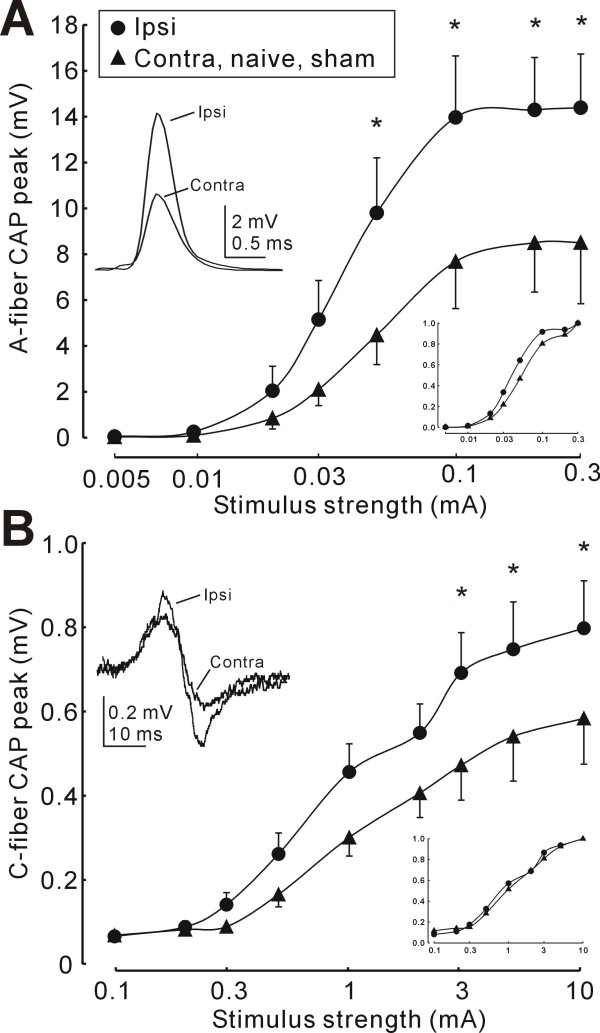
Increased excitability of ipsilateral sciatic nerve after SNE. A: Stimulus-output plot of A-fiber CAP peak for sciatic nerve ipsilateral to SNE (n = 8) compared to preparations from contralateral, naïve or sham control rats (n = 8). Inset (left) shows examples of ipsilateral and contralateral A-fiber CAP with peaks aligned for clarity (0.1 mA stimulus). *, p < 0.05 (two-way ANOVA, Tukey post-hoc). Inset (bottom right) shows normalized data with error bars removed for clarity. Note the leftward shift of data from ipsilateral nerves. B: Stimulus-output plot of C-fiber CAP peak for sciatic nerve ipsilateral to SNE compared to preparations from contralateral, naïve or control rats. Inset (left) shows examples of ipsilateral and contralateral C-fiber CAP (10 mA stimulus). Inset (bottom right) shows normalized data with error bars removed for clarity. Stimulus durations were 0.1 ms and 0.5 ms for A- and C-fiber CAP, respectively throughout. Tissue was harvested 2 weeks after SNE or sham surgery.